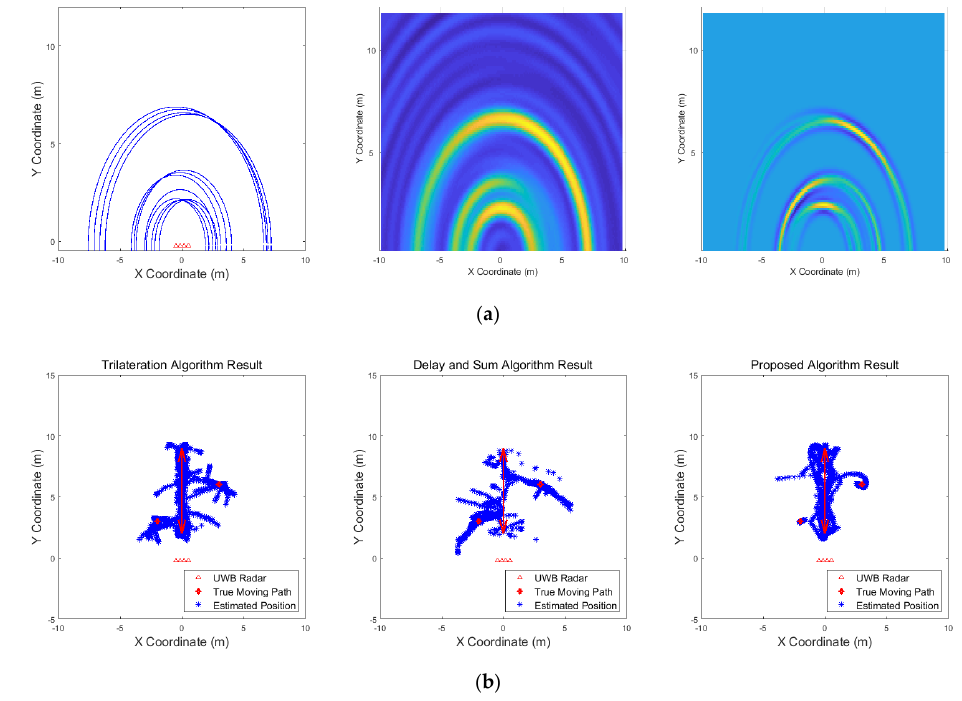
Figure 16. Simulation results when two targets move and one target stands (Scenario 8): ( a ) instantaneous results of position estimation step according to the positioning algorithm; ( b ) results of the radar system for the entire simulation.